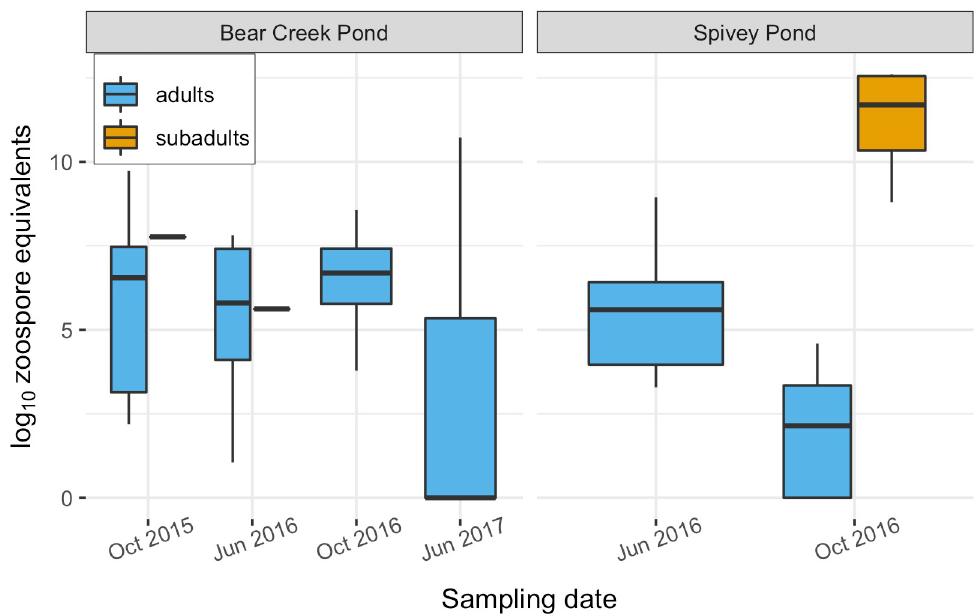
Fig 2. Batrachochytrium dendrobatidis (Bd) loads in Bd-positive California red-legged frogs ( Rana draytonii ) at two translocation donor populations in El Dorado County, California, U.S.A. Box widths are proportional to sample size, bold horizontal lines within each boxplot indicate the median, boxes show the interquartile (IQ) range, and whiskers show the range within 1.5 times the IQ range. https://doi.org/10.1371/journal.pone.0241119.g002 Twenty-two years of Spivey Pond R . draytonii monitoring indicate that life stages and egg mass counts were variable across years (Fig 4). Increased detection of frogs in 2014, 2015, and